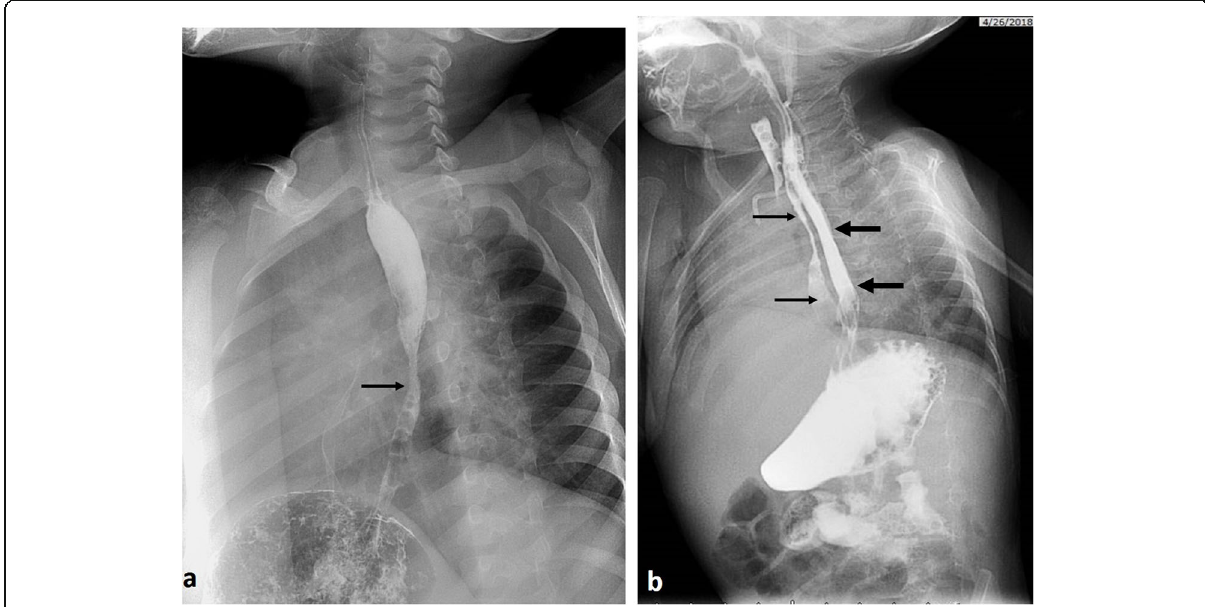
Fig. 6 Two patients with esophageal findings. a A 3-year-old boy complaining of vomiting and dysphagia showing peptic stricture (arrow). b A 3-month-old girl presented with unresolved chest infections since birth and history of suction of secretion at birth; oblique view shows evidence of false passage, evident by the presence of false lumen (thin arrows) with true esophageal lumen (thick